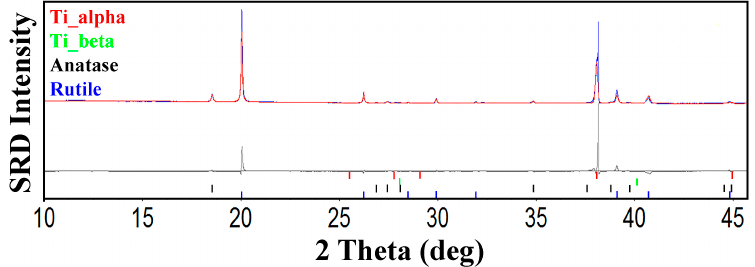
Figure 5. SRD Rietveld difference plots for anodized titania nanotube arrays data measured at 900 °C. Black crosses show measured patterns and solid red lines show calculated patterns. Difference between measured and calculated patterns are shown by the gray residual plot. Red, green, black, and blue bars show peak positions for Ti α , Ti β , anatase and rutile, respectively. The plots were computed with TOPAS (Version 4.2).